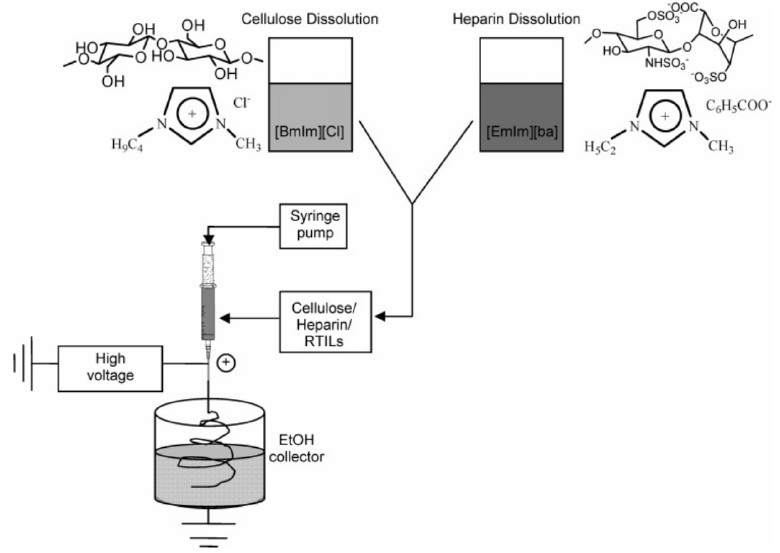
Figure 1. Schematic representation of the electrospinning process used to make heparin–cellulose fibers from the IL solutions. Reprinted with permission from [72]. Copyright 2006 American Chemical Society.